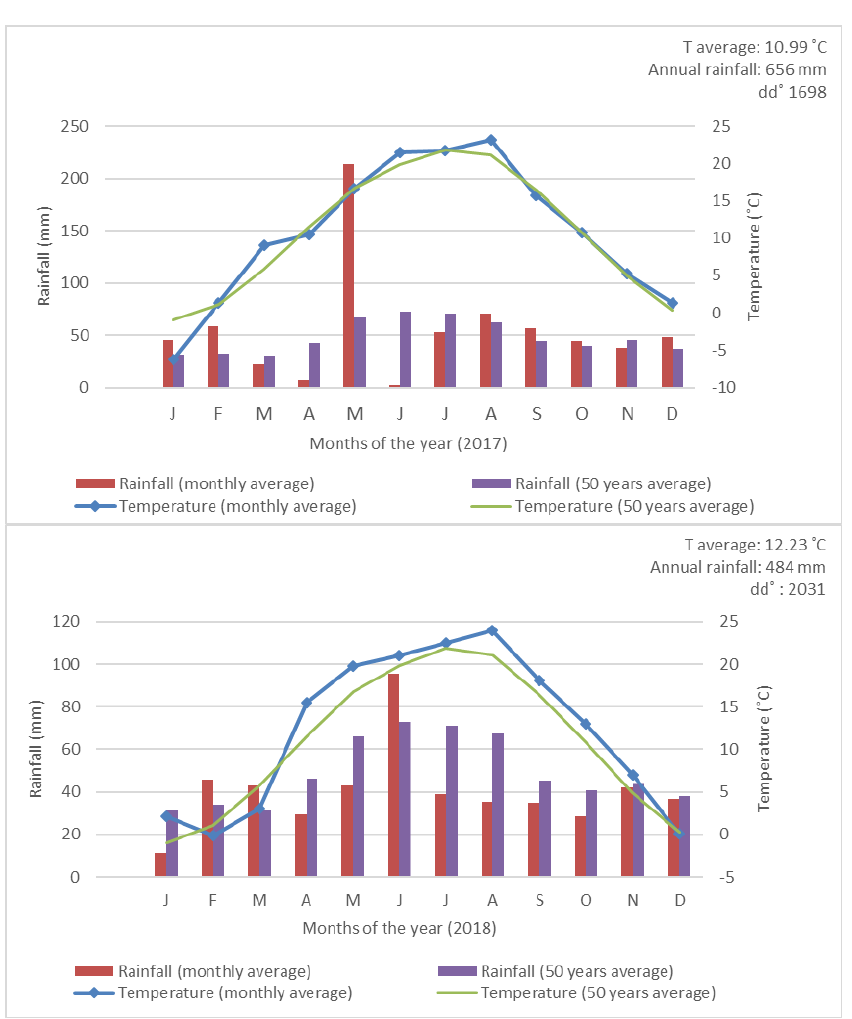
Figure 1. Monthly average air temperature (line) and monthly precipitation (bars) in 2017 and 2018 (Eger,